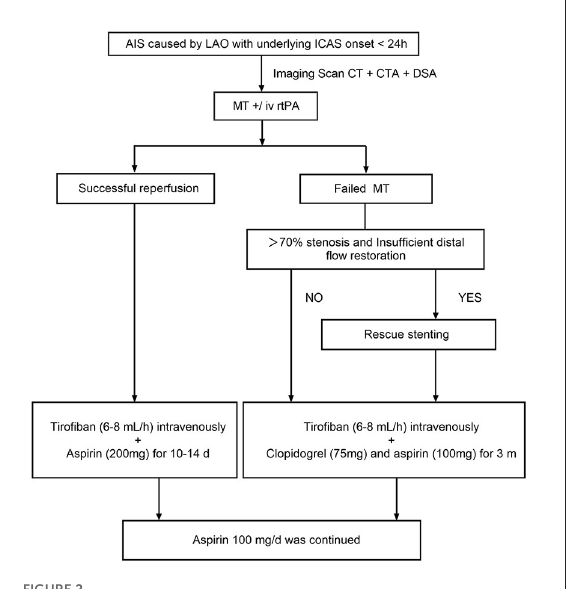
FIGURE2 Flow chart of the MT process in out center. AIS, acute ischemic stroke; LVO, intracranial large vessel occlusion; CT, computed tomography; CTA, computed tomographic angiography; DSA, digital subtraction angiography; MT, mechanical thrombectomy; rtPA, recombinant tissue plasminogen activator. MT + / iv rt PA, iv rtPA is performed if the patient is within 4.5h of